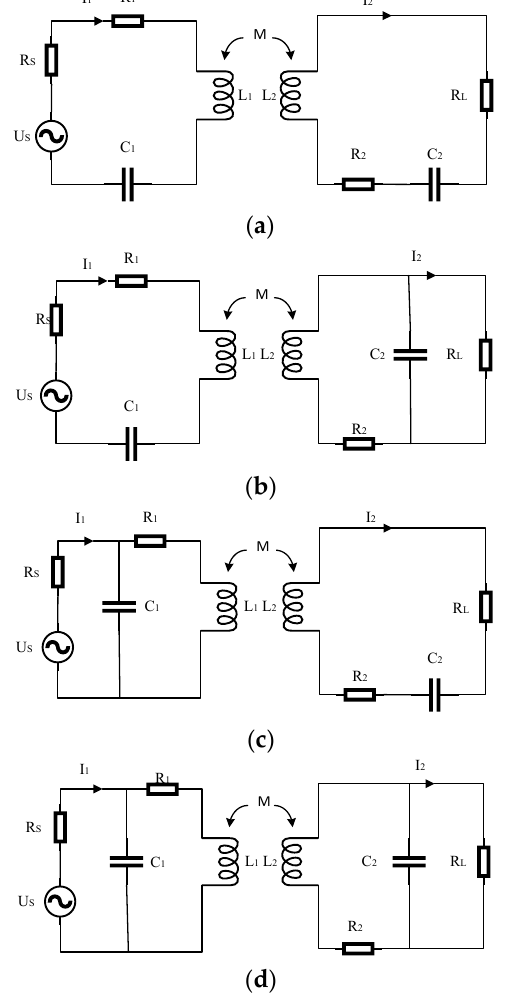
Figure 3. Equivalent circuit of topological structure: ( a ) SS topology structure; ( b ) SP topology structure; ( c ) PS topology structure; ( d ) PP topology structure.